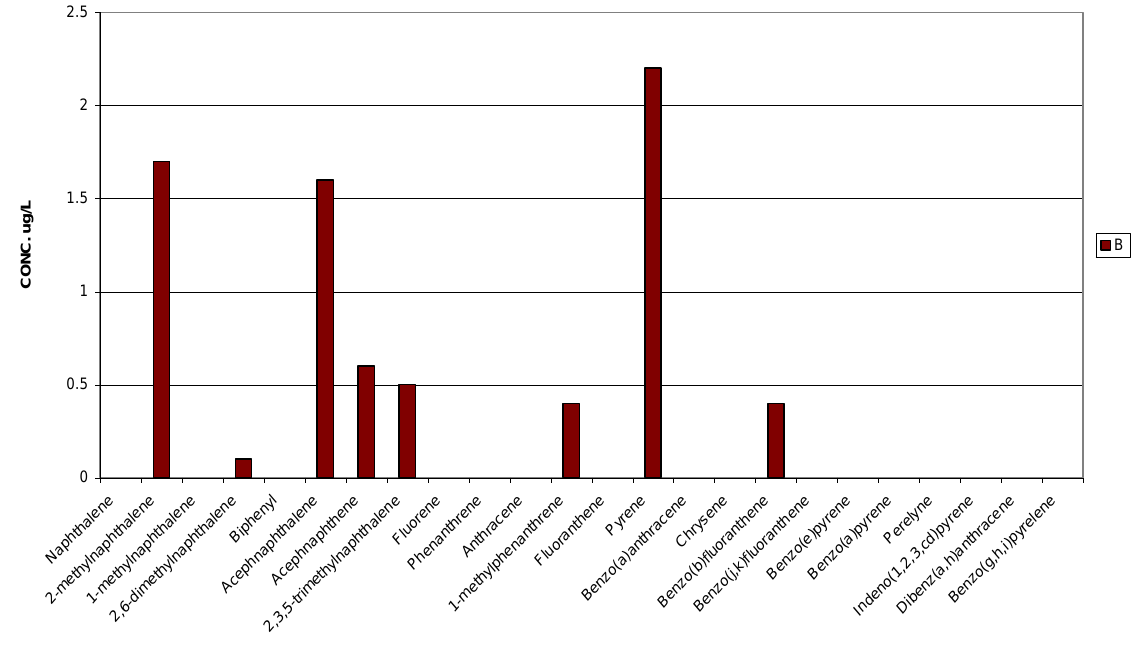
FIGURE 4. The average PAHs found in the Benya Lagoon